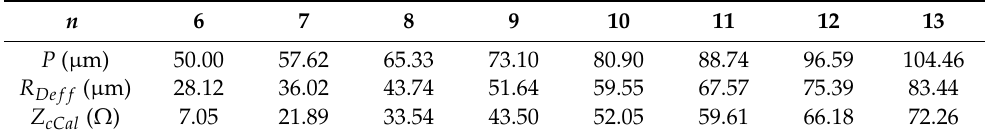
Table 1. Calculated R Def f and Z cCal of the coaxial-like TSVs.